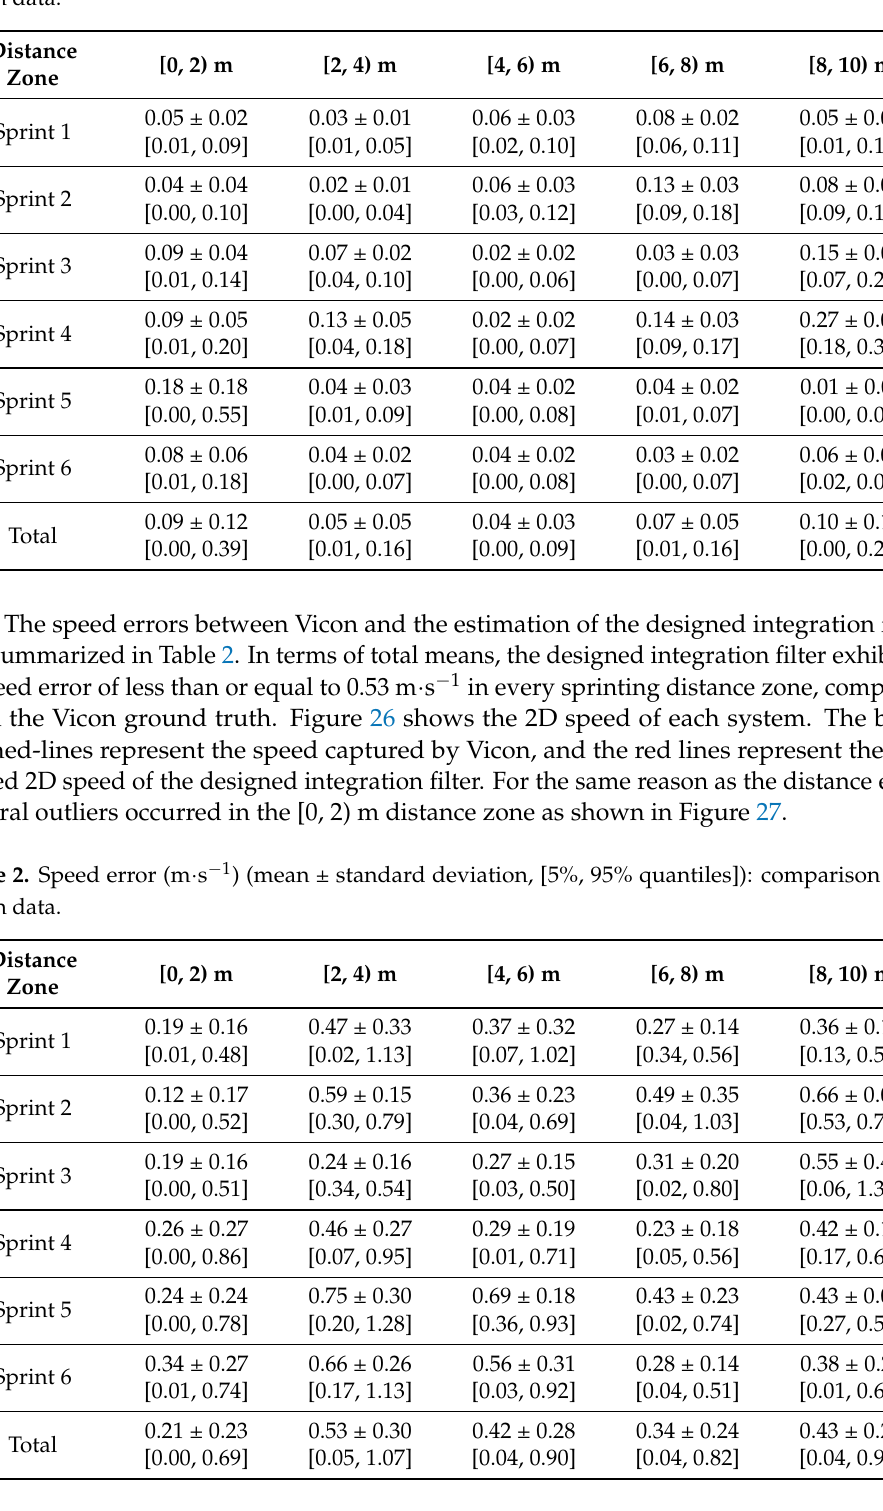
Table 1. Distance error (m) (mean ± standard deviation, [5%, 95% quantiles]): comparison with Vicon data.